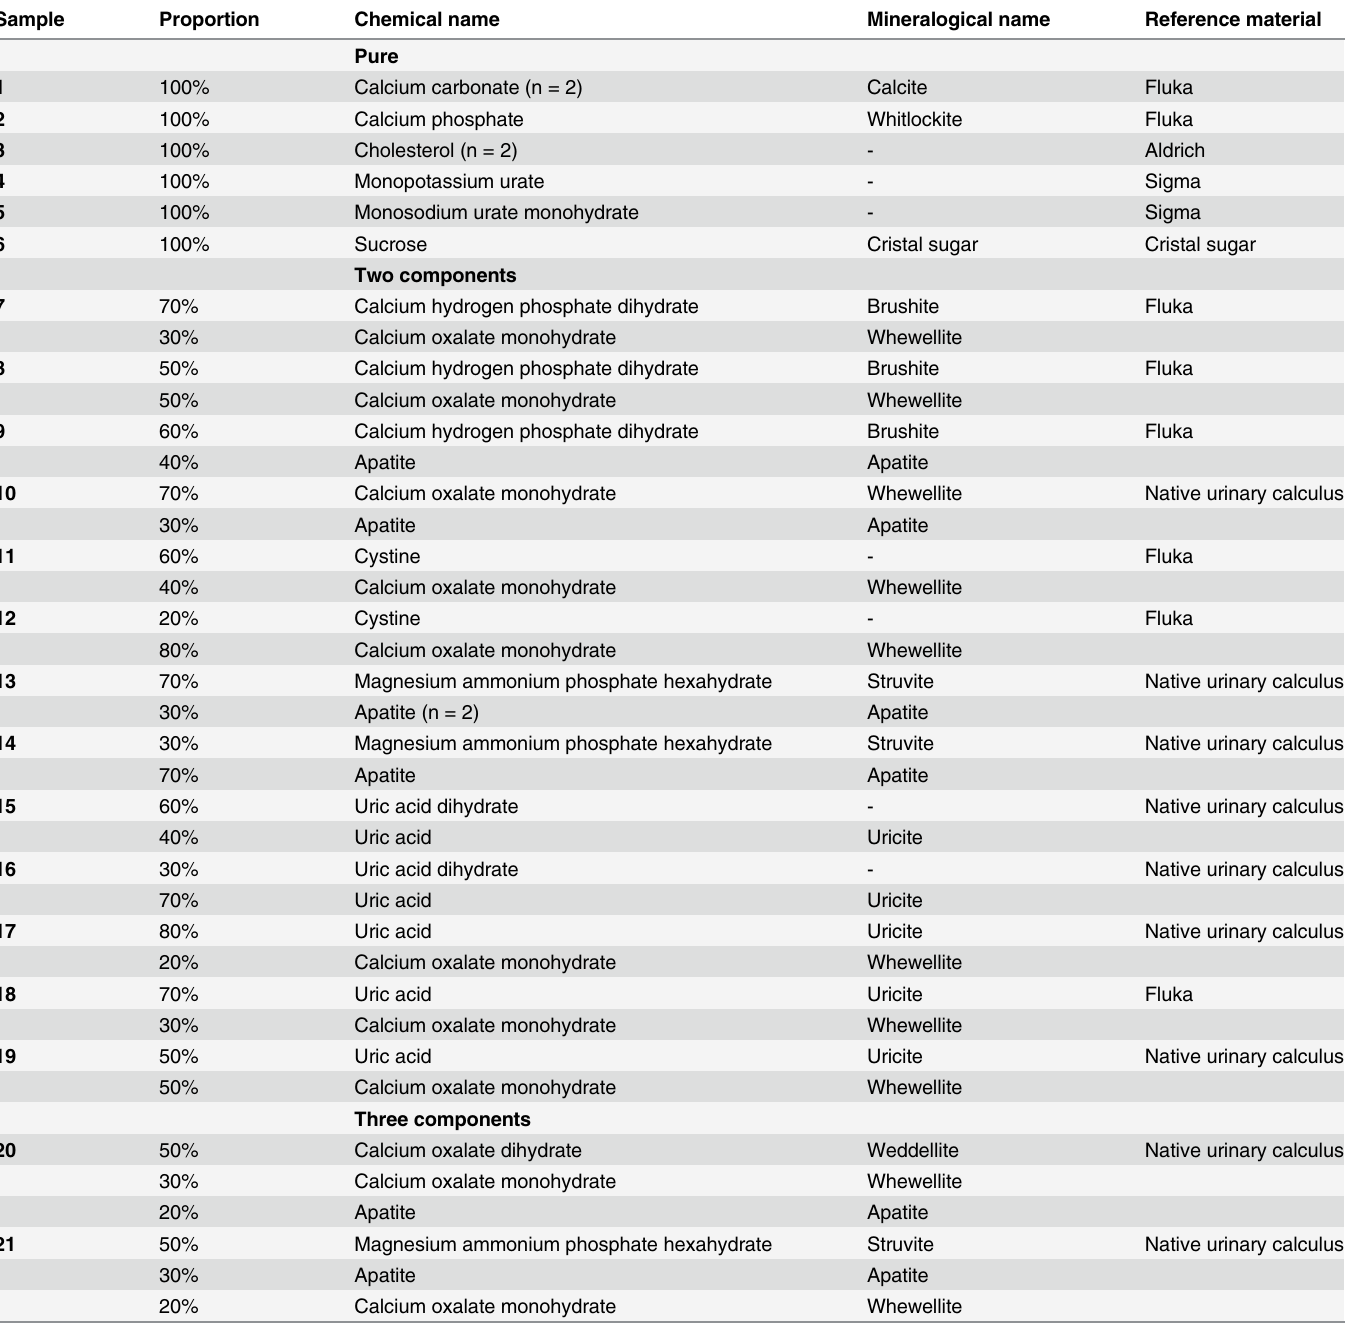
Table 1. Test substances for